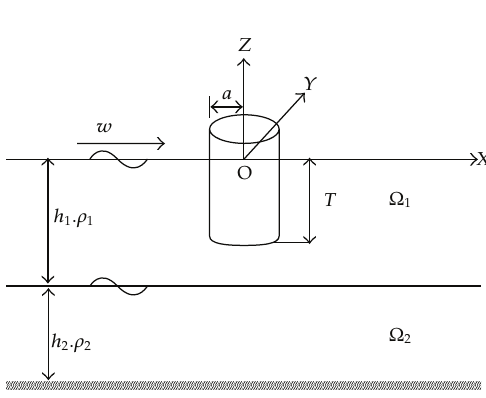
Figure 2: Definition of sketch for a truncated cylinder.